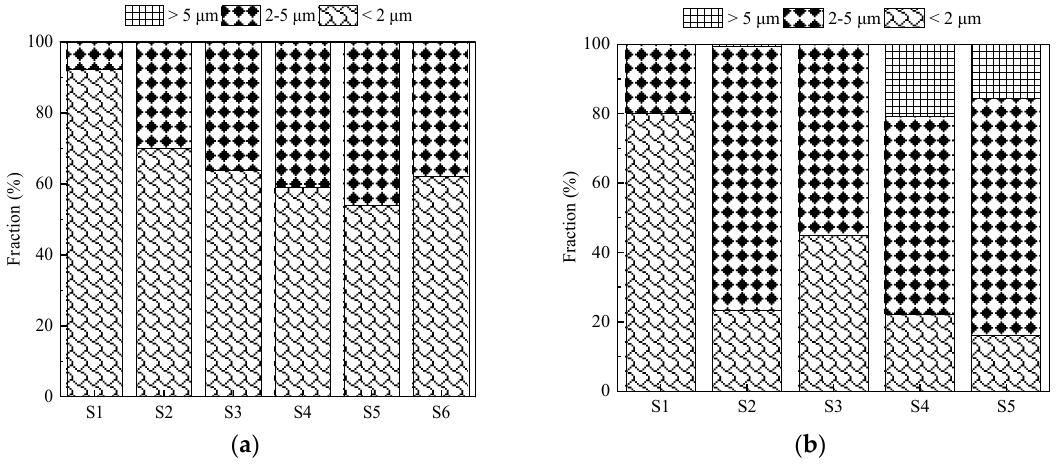
Figure 5. The particle size distribution of AlN primary class for ( a ) 533N-P and ( b ) 533N-I steels.